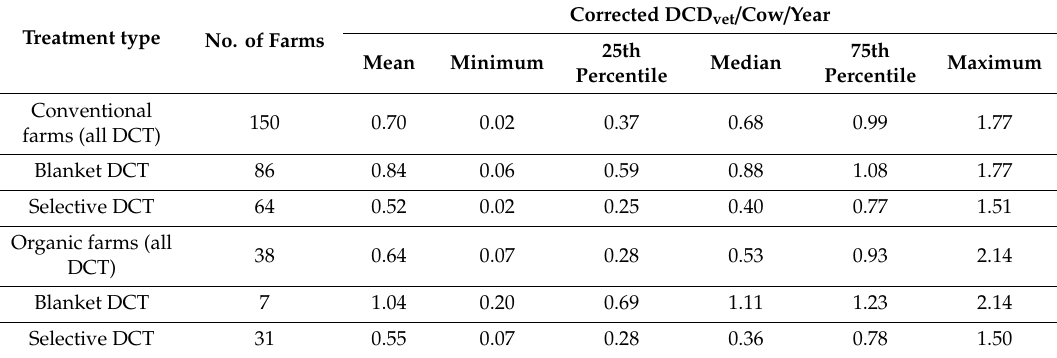
Table 2. Antimicrobial dry cow therapy by production system, based on antimicrobial data from veterinary practice software (n = 188).